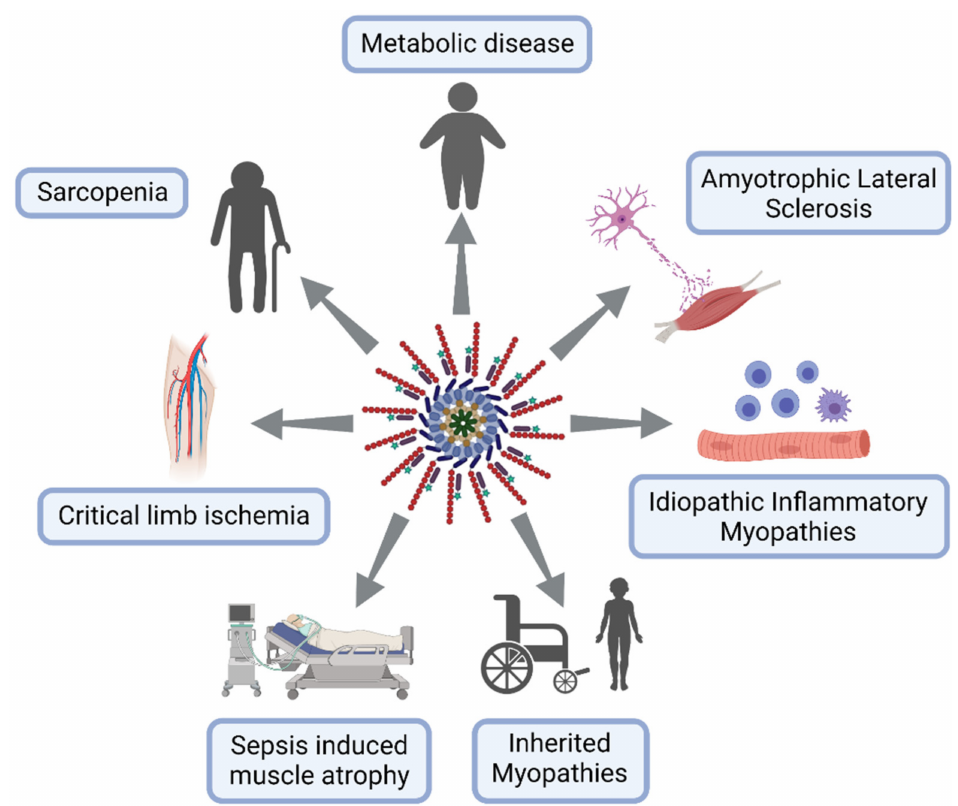
Figure 3. NLRP3 inflammasome excessive activation in skeletal muscle diseases. Lymphocytes in blue, macrophages in purple and neuron in